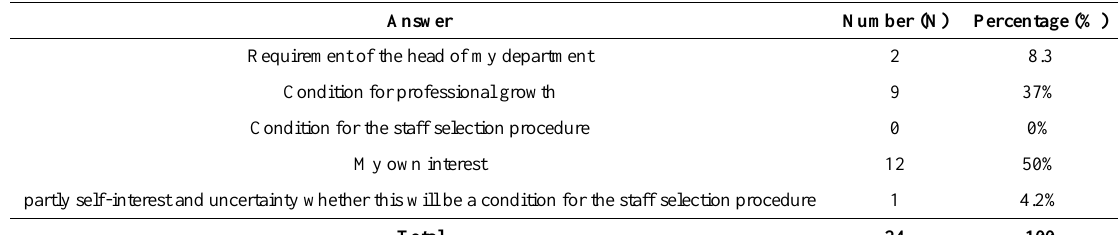
Table 1. Motivation to complete the Course in Academic